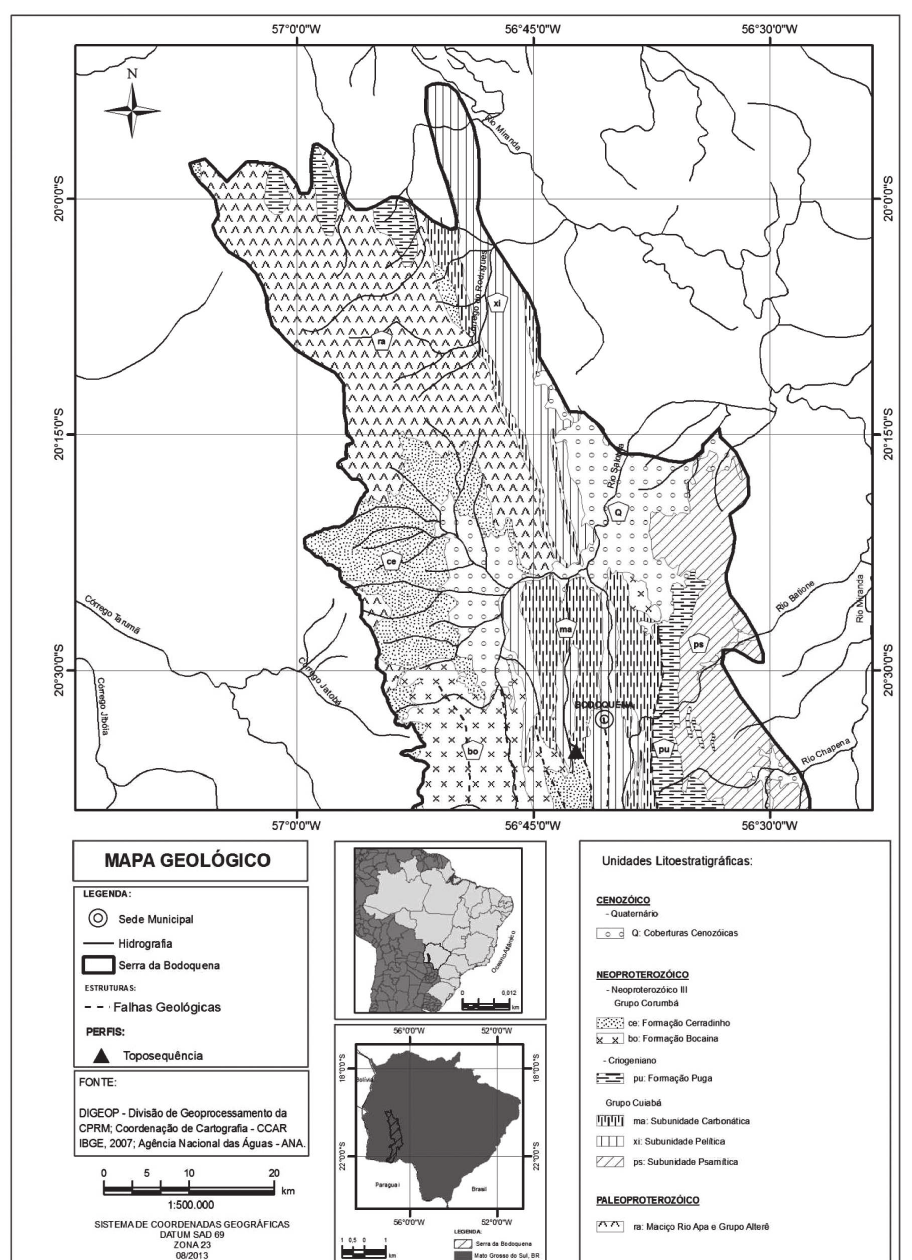
Figura 1. Mapa de localização da área estudada e geologia da porção norte da Serra da Bodoquena,